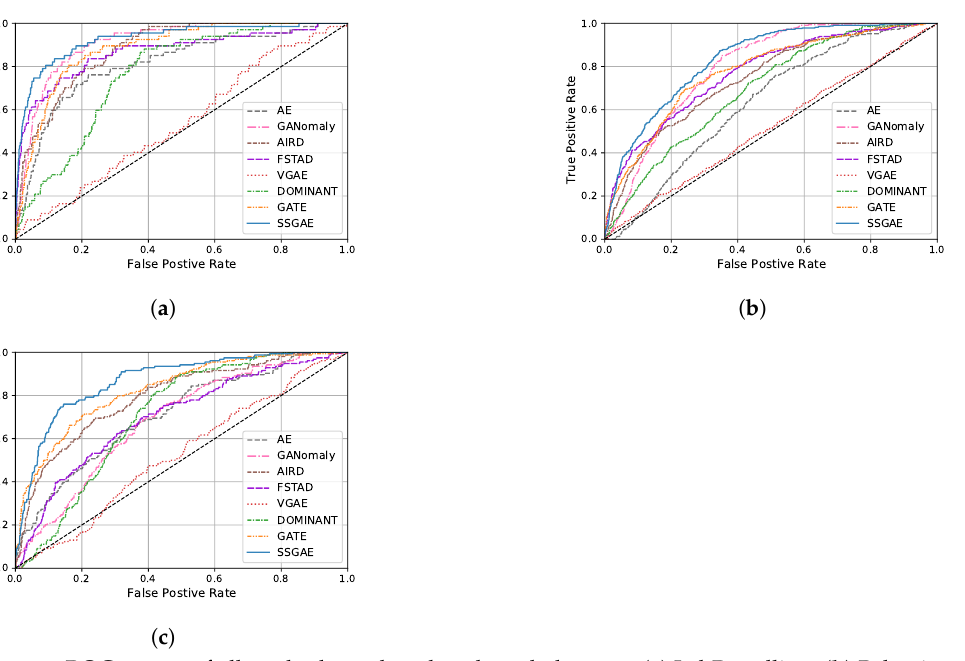
Figure 6. ROC curves of all methods on three benchmark datasets. ( a ) LabPatrolling. ( b ) Behavior- Monitoring. ( c )